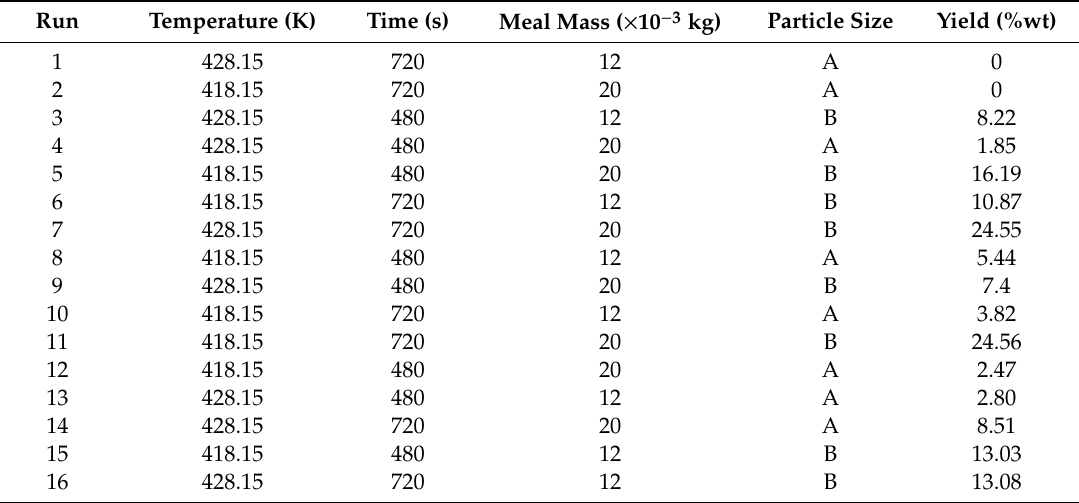
Table 1. Screening experimentation results.